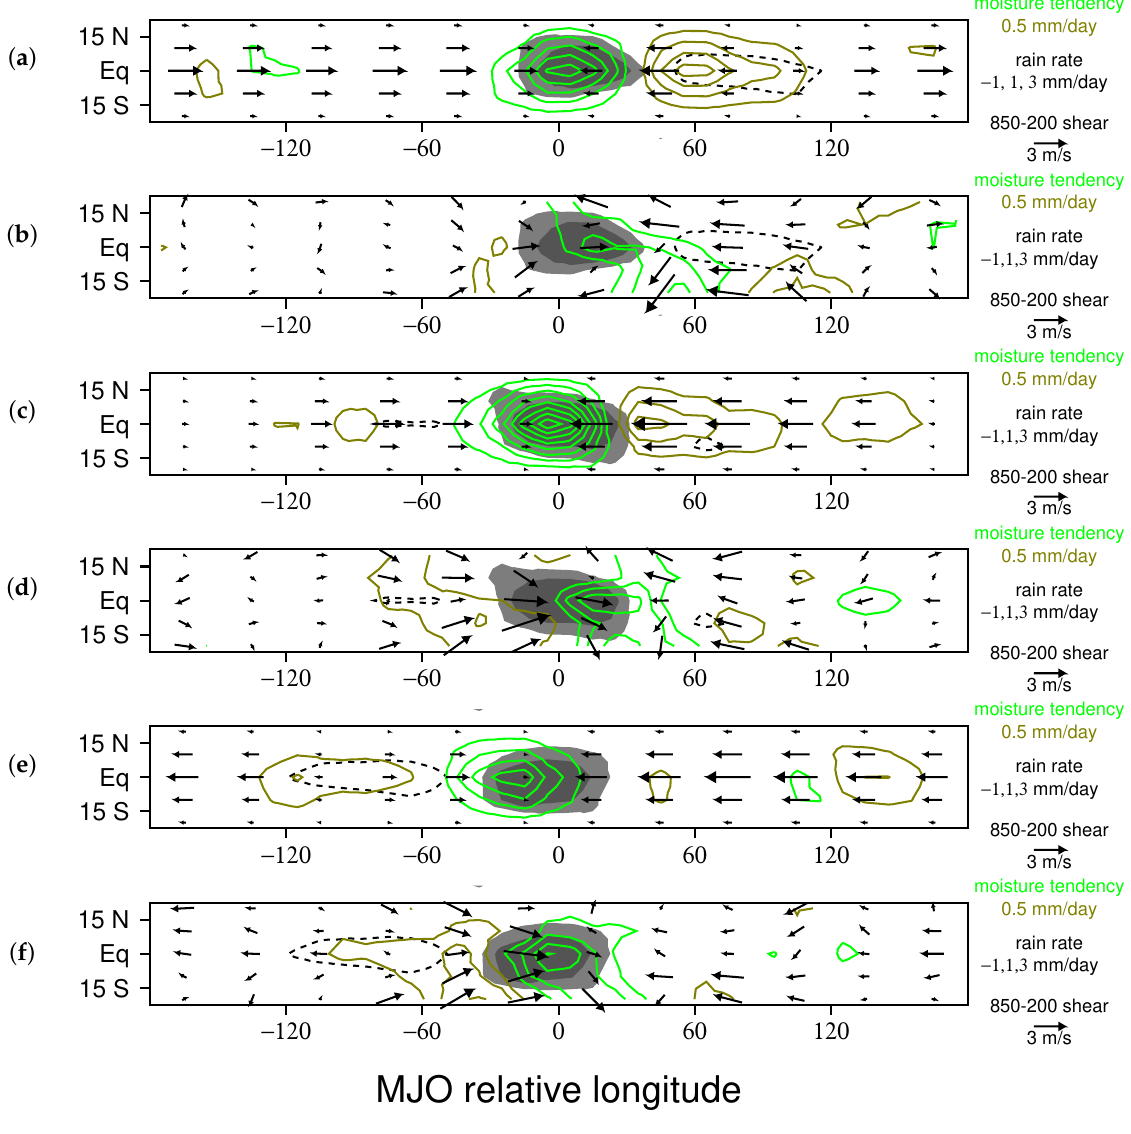
Figure 8. Moisture tendency owing to advection from the Kelvin ( a , c , e ) and Rossby ( b , d , f ) com- ponents of the LAM MJO for the developing, mature, and dissipating stages, respectively. Green (brown) contours indicate moistening (drying), and vectors show the difference between 850 and 200 hPa flow. Regions with rainfall greater than 1 and 3 mm/day are shaded light and dark gray, respectively. The − 1 mm/day rainfall contour is marked with a dashed